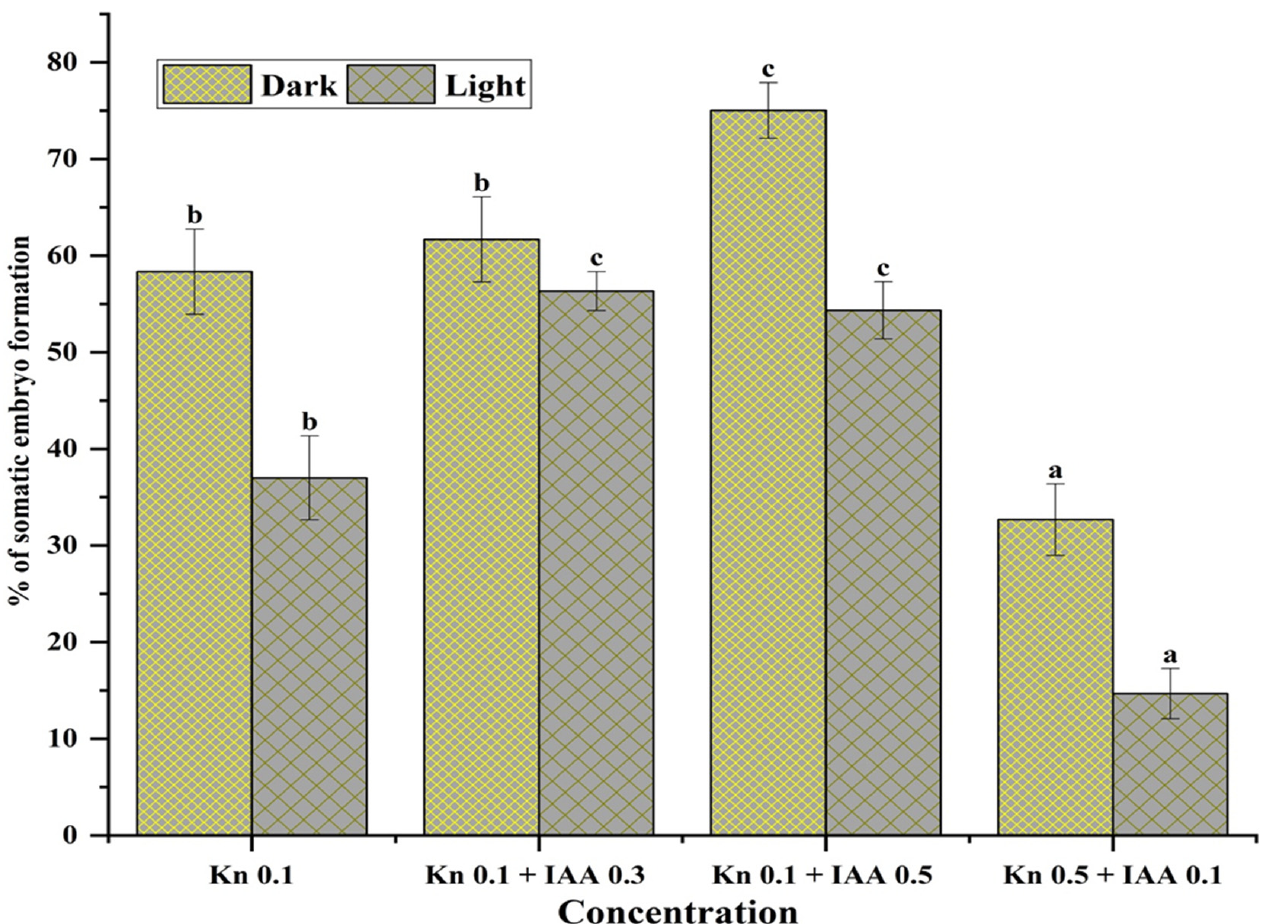
Figure 3. Influence of light conditions and concentrations of Kn and IAA (mg L − 1 ) on somatic embryo formation from the embryogenic callus of Aconitum violaceum . Mean value ± standard error mean followed by different letters in each column represents that the observations were substantially different according to DMRT (one-way ANOVA) at p ≤ 0.05. Abbreviations: Kn: kinetin. IAA: indole-3-acetic acid. Table 3. Effect of Kn and IAA on whole plant regeneration from somatic embryos and in vitro rooting in Aconitum violaceum